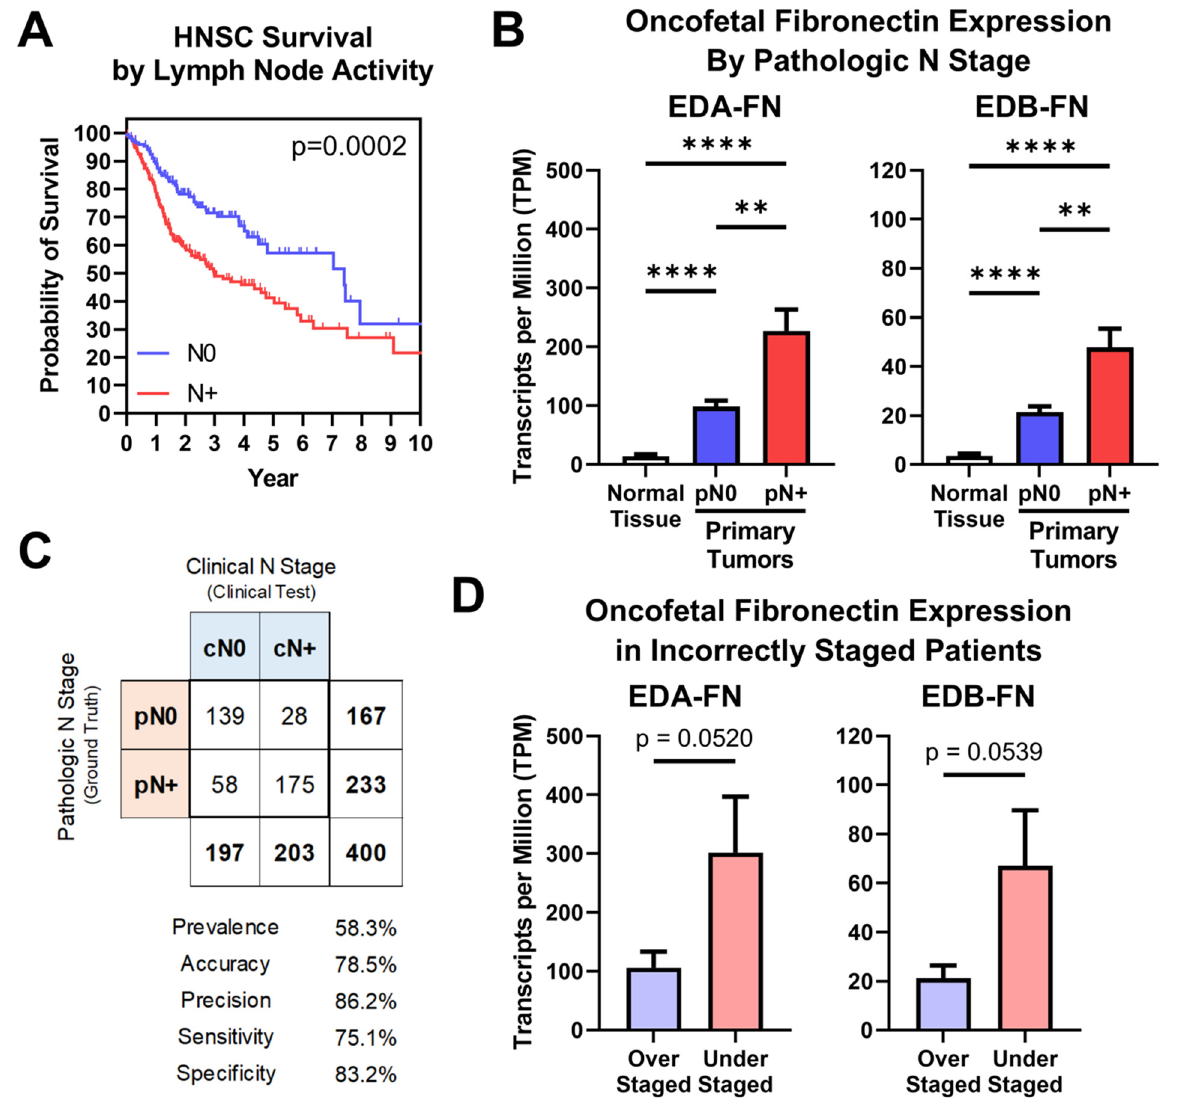
Figure 6. Oncofetal FN expression and lymph node activity. ( A ) Kaplan–Meier survival curves for HNSC patients diagnosed N0 ( n = 174) and N+ ( n = 243). ( B ) Oncofetal FN expression in normal HNSC tissue ( n = 99) and primary tumors pathologically staged N0 ( n = 174) or N+ ( n = 243). ( C ) Binary classification comparing clinical N stage (cN; clinical test) with pathologic N stage (pN; ground truth). Binary classification statistics are provided. ( D ) Oncofetal FN expression in over-staged ( n = 28) and under-staged ( n = 58) HNSC patients. Significance: **, p < 0.01; ****, p < 0.0001.